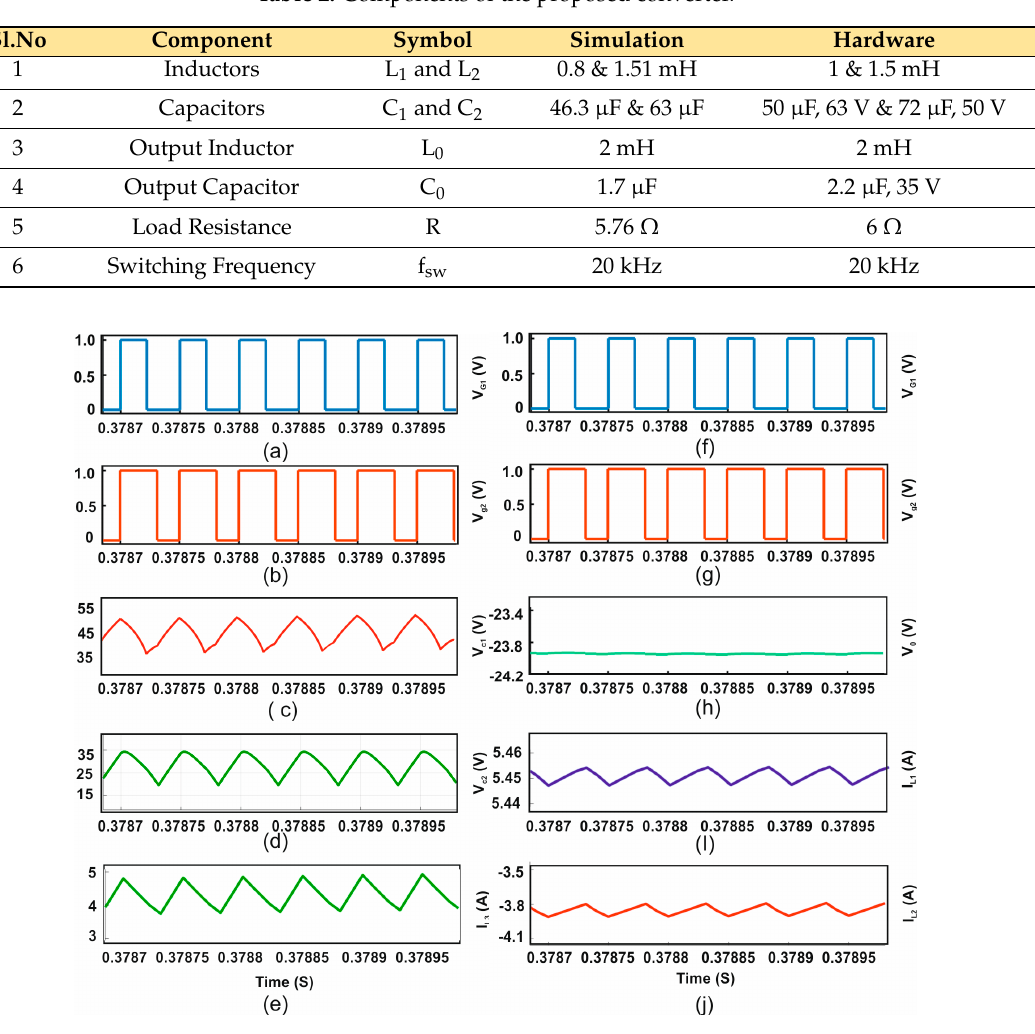
Figure 9. Waveforms of various voltages and currents during mode 2 ( a,f ) Gate signal to S 1 , ( b,g ) Gate signal to S 2 , ( c ) Voltage across capacitor C 1 , ( d ) Voltage across capacitor C 2 , ( e ) Current through the inductor i 3 ( h ) Output voltage ( i ) Current through the inductor L 1 ( j ) Current through the inductor L 2.